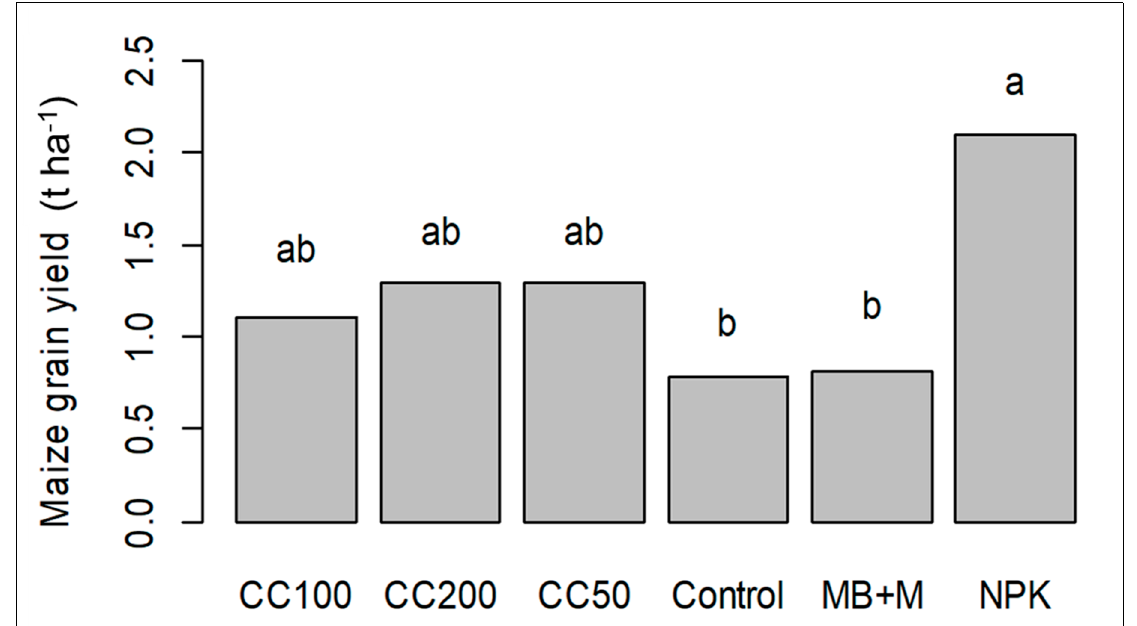
Figure 4. Maize grain yield in response to maize–mung bean intercropping (MB + M), ComCat ® (CC) treatments at rates of 50, 100, and 200 g ha − 1 and mineral fertilizer application (NPK) at Banikoara, Benin, 84 DAS. Means with identical letters above columns do not differ significantly based on Tukey’s HSD test ( p ≤ 0.05).